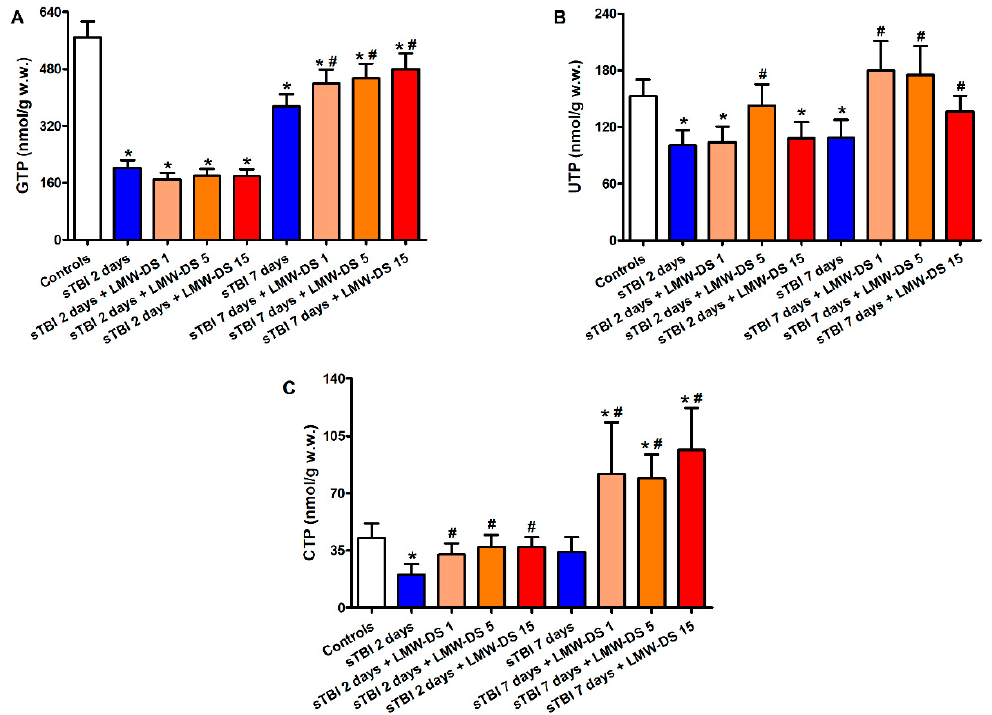
Figure 3. Effect of subcutaneous injection of increasing doses of LMW-DS (ILB ® ) on the cerebral concentrations of GTP ( A ), UTP ( B ), and CTP ( C ), as valuable indicators of the nervous cell energy state. The parameters of interest were determined by HPLC on deproteinized cerebral homogenates at 2 and 7 days post-impact, both in untreated sTBI rats (TBI 2 days and TBI 7 days) and in rats receiving 1, 5, or 15 mg/kg b.w. LMW-DS (ILB ® ) administered 30 min after sTBI. Controls are represented by sham-operated rats. Values are the mean ± SD of 12 different animals and are expressed as nmol/g w.w. * Significantly different from sham-operated control rats, p < 0.05. # Significantly different from the corresponding time point of untreated sTBI rats, p < 0.05.